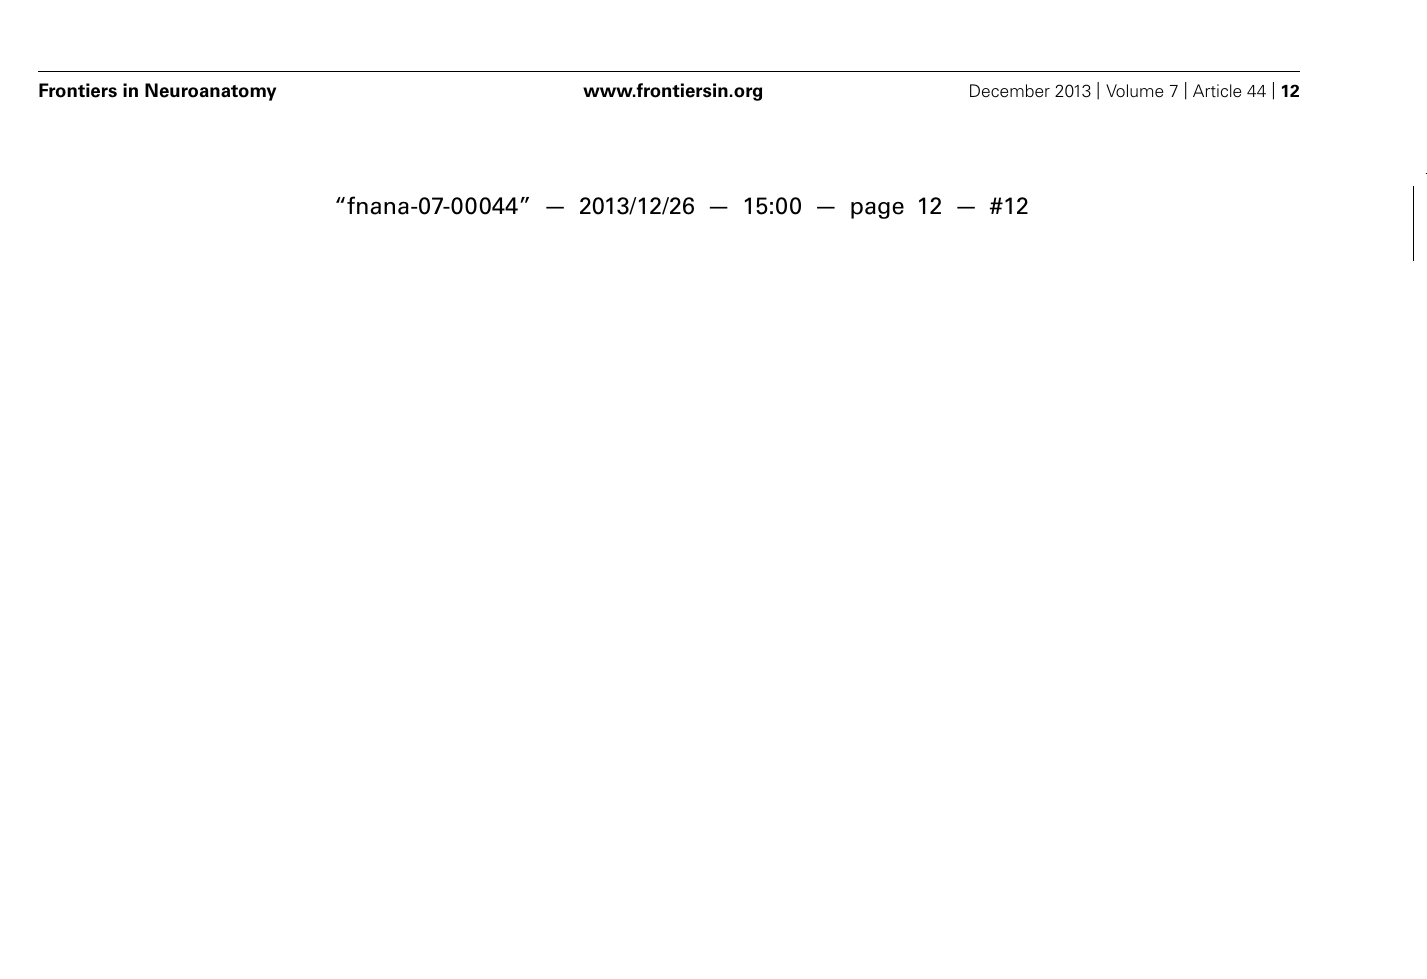
FIGURE 8 |Treatment with CNTF or C16 reduced the number of apoptotic neural cells in the brain cortex and spinal cord. (A–H) Caspase-3 immunostaining, counterstained with hematoxylin, bar = 100 μ m. [ (A,C,E,G) : coronal sections of brain motor cortex; (B,D,F,H) : traverse sections through anterior horn of lumbar spinal cord]. At week 2 post-immunization, vehicle-treated EAE rats (A) : many caspase-3 labeled apoptotic neural cells appeared in the hindlimb area of the motor cortex; (B) plenty of caspase-3 labeled apoptotic neural cells appeared in the anterior horn of the spinal cord). In CNTF − (C,D) , C16 − (E,F) , and C16 + CNTF-treated (G,H) rats, the density of caspase-3